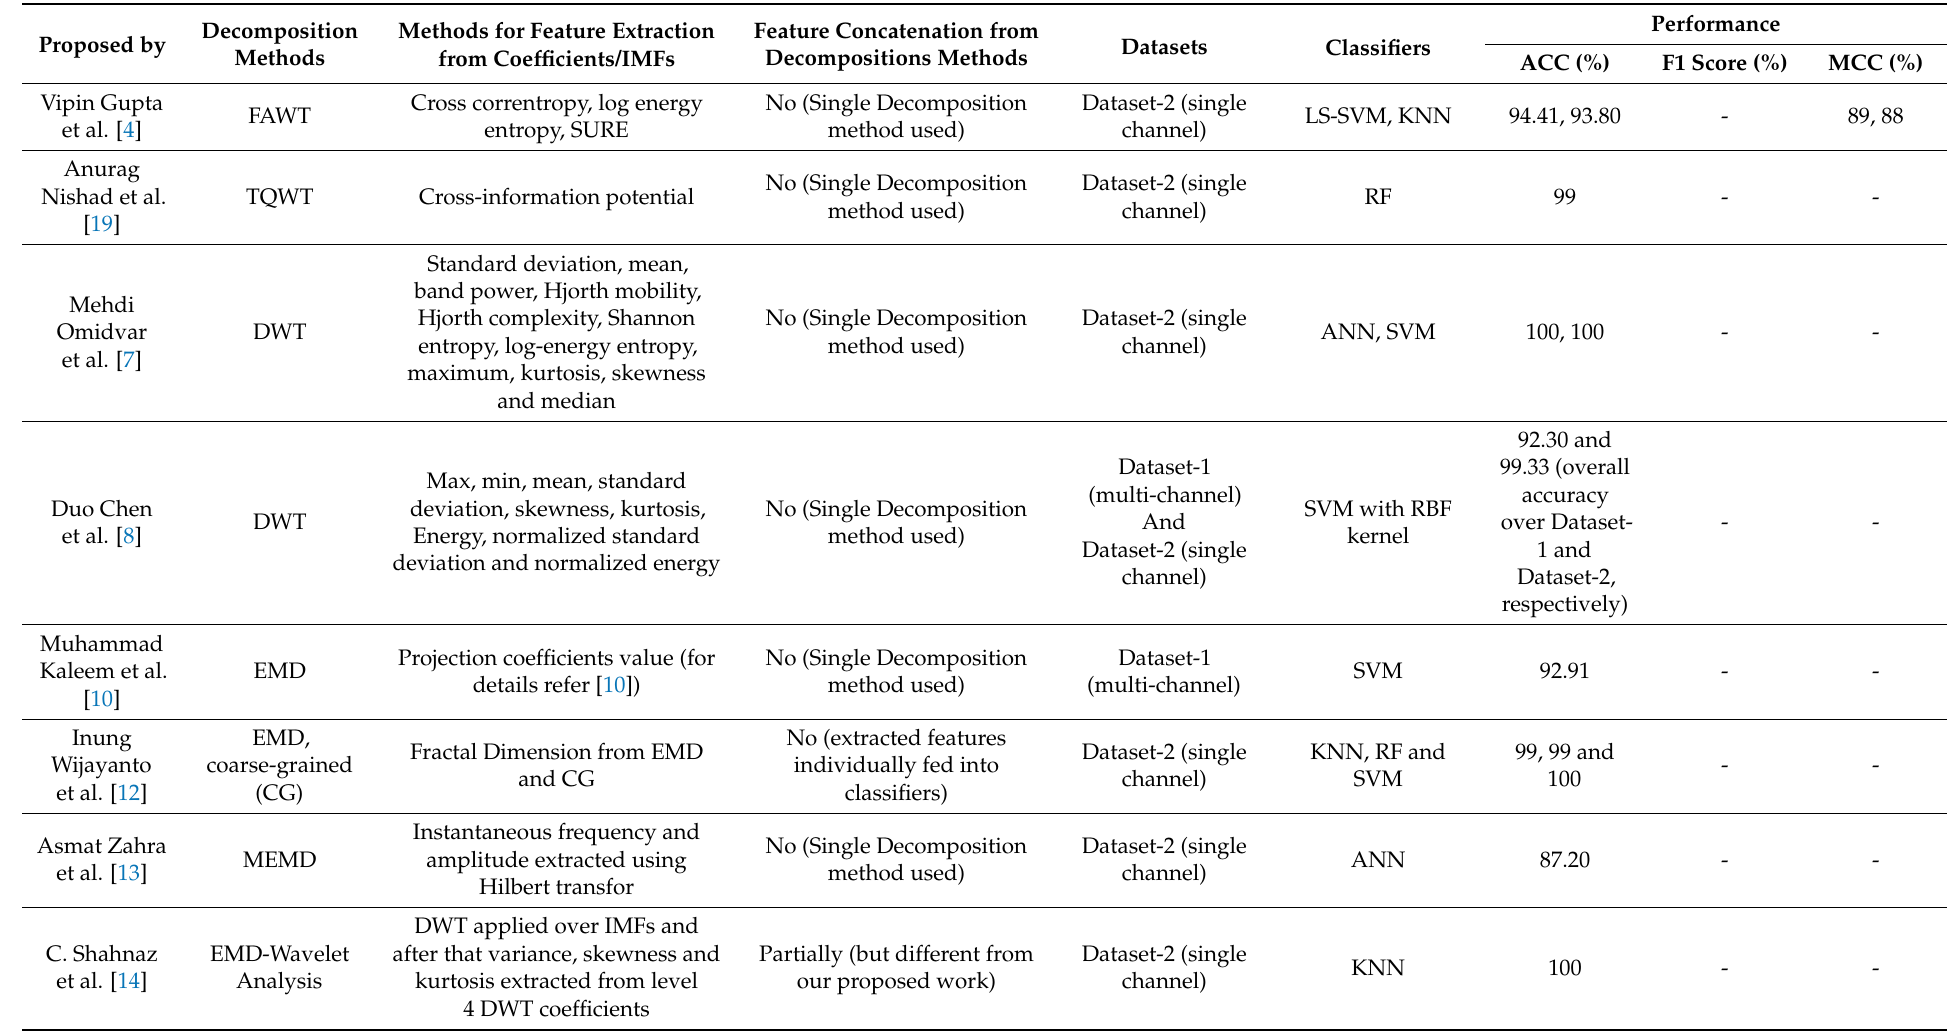
Table 8. Comparison with existing